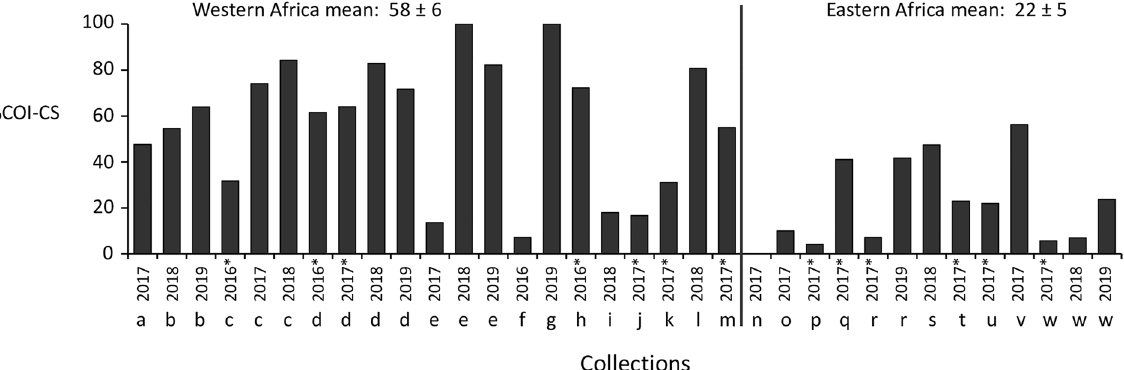
Figure 3. Bar graph describing COI haplotype frequencies in western and eastern Africa. Collections are as described in Table 1. The mean ± the Standard Error of the Mean (SEM) for different regions is presented above the graph. Asterisks indicate data from earlier